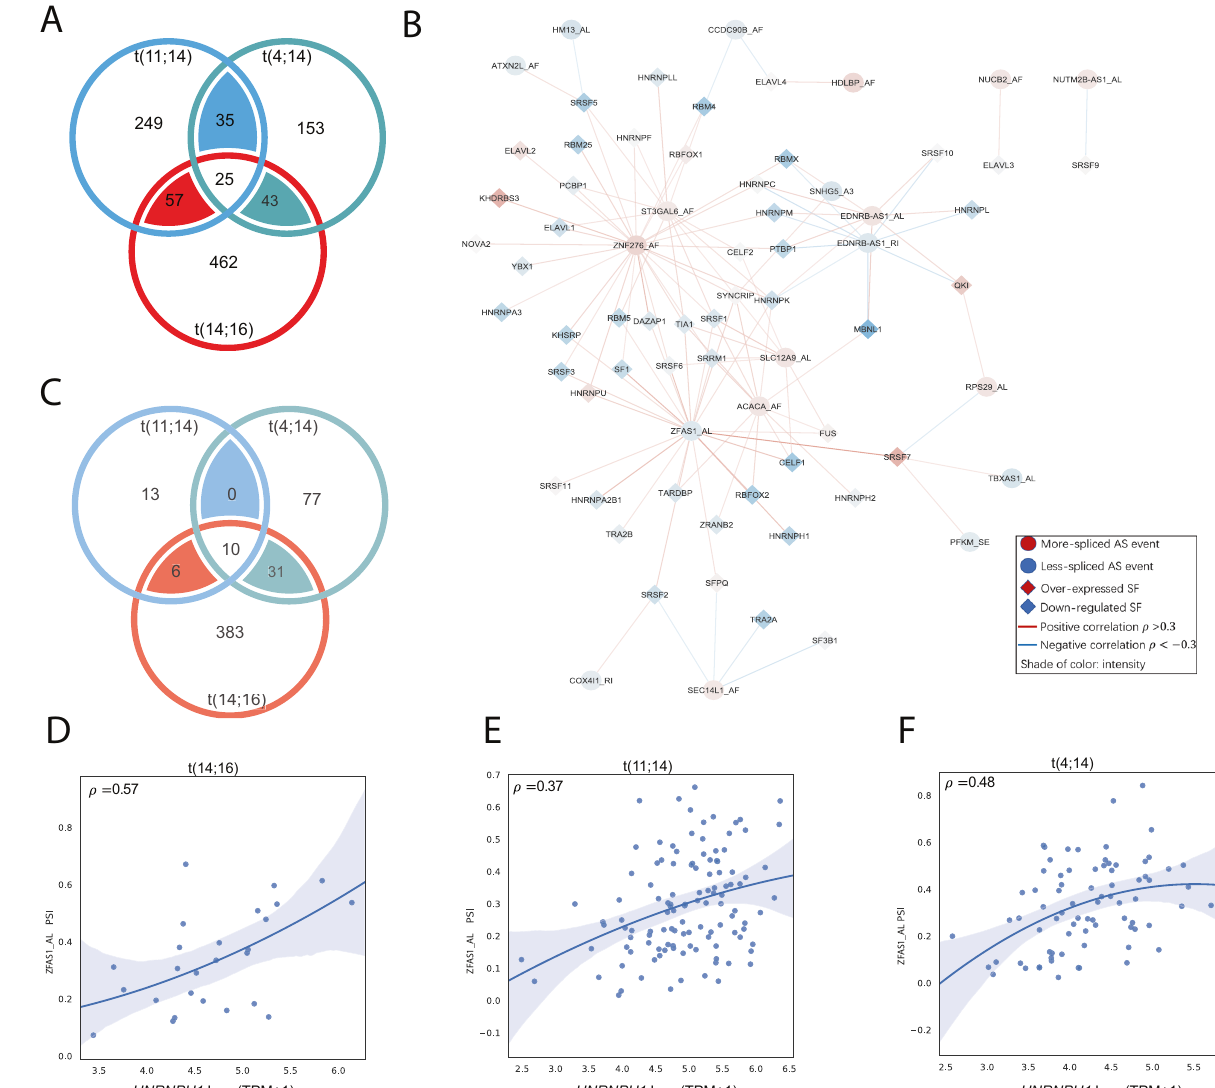
Fig. 5 Activity of splicing factors (SF) is associated with the alternative splicing (AS) levels among translocations. A Venn diagrams indicating the consistent events among three translocations. B SF-AS correlation network among t(4;14) samples and consistent high-quality events among translocations. Spearman correlations were indicated by edges while log-fold-change of expression levels of SFs and dPSI of AS events were indicated by node. C Venn diagrams indicating the consistent high SF-AS correlations (>0.3) among 25 consistent events from ( A ). D – F An example SF-AS correlation consistently across component of spliceosome, but chaperone proteins that are recruited as cellular response toward DNA damage [42 – 44]. Second, DNA damage response can regulate splicing factors through expression changes, post-translational modi fi cations, and cellular re-localization [41, 45]. SRSF10 and SRSF6 have been shown to connect these two mechanisms in vitro [46, 47], and we provided evidence to indicate the existence of both mechanisms in MM. Hence, it is no surprise to see the deterministic role of NHEJ in shaping the alternative splicing landscape in NDMM. We detected ~5-fold more structural variants in the samples with high expression of NHEJ genes, and speculate that these are more genomically unstable, resulting in more SVs that trigger a highly upregulated NHEJ pathway activity, which further leads to more aberrant AS events. Taken together, we consider SV-NHEJ-AS as an interacting network, in which each component may potentially serve as a biomarker of high-risk disease or novel molecular vulnerability.